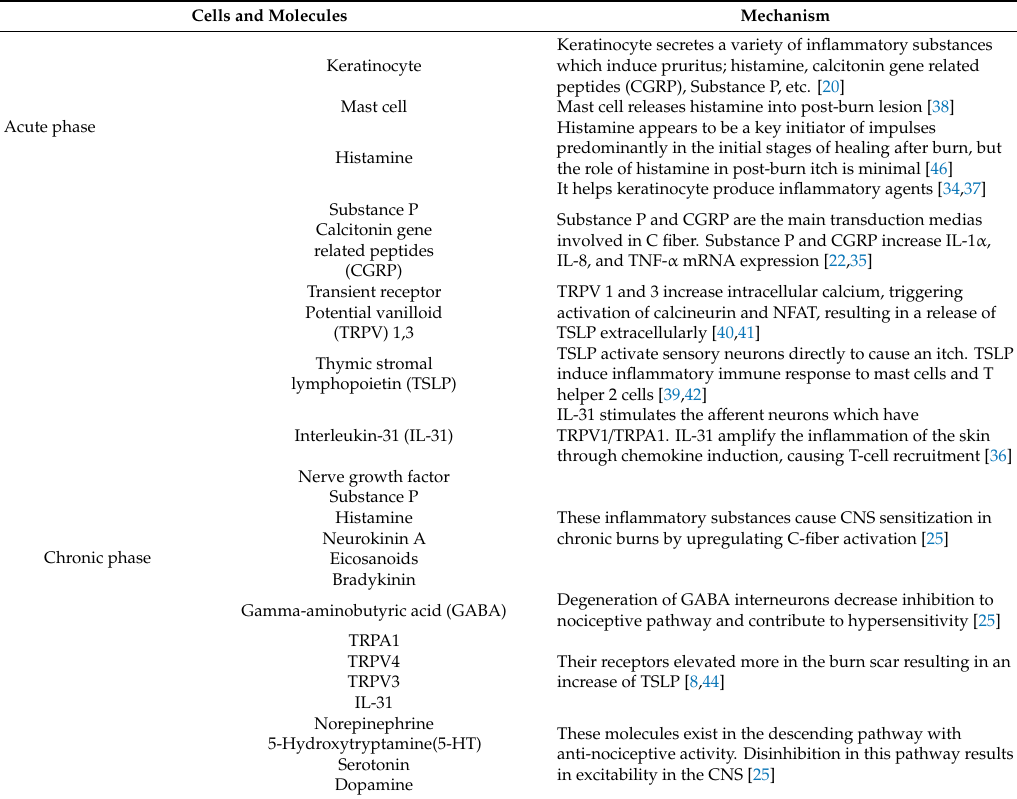
Table 1. Cells and molecules involved in the pathophysiology for post-burn